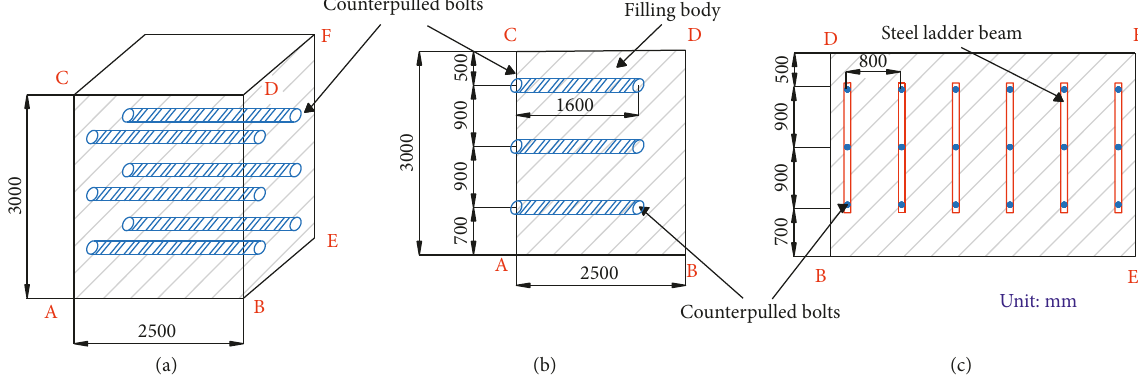
Figure 16: The support parameters of the filling body: (a) cubic view; (b) cross-sectional view; (c) lateral view.